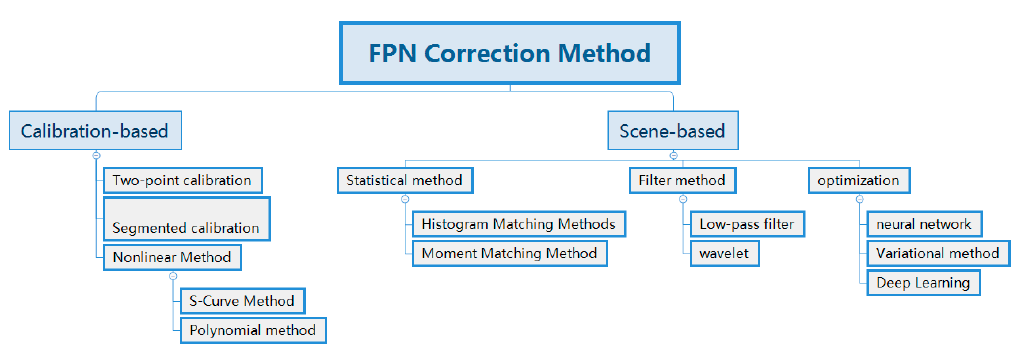
Figure 3. Summary of FPN correction methods.